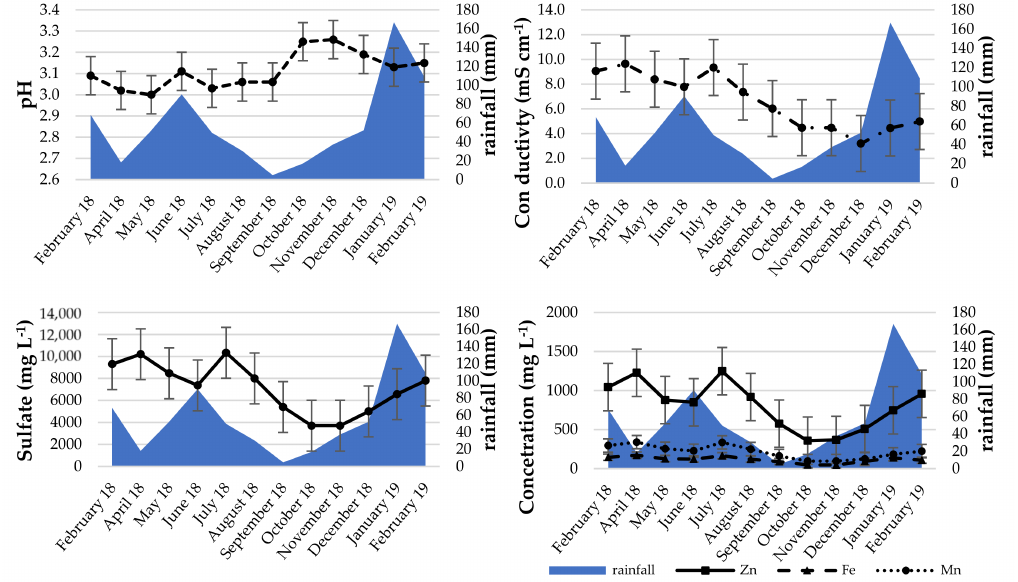
Figure 4. Evolution of selected parameters in AMD with rainfall data. Metrological seasons: Spring: 1 March to 31 May; Summer: 1 June to 31 August; Autumn: 1 September to 30 November; Winter: 1 December to 28